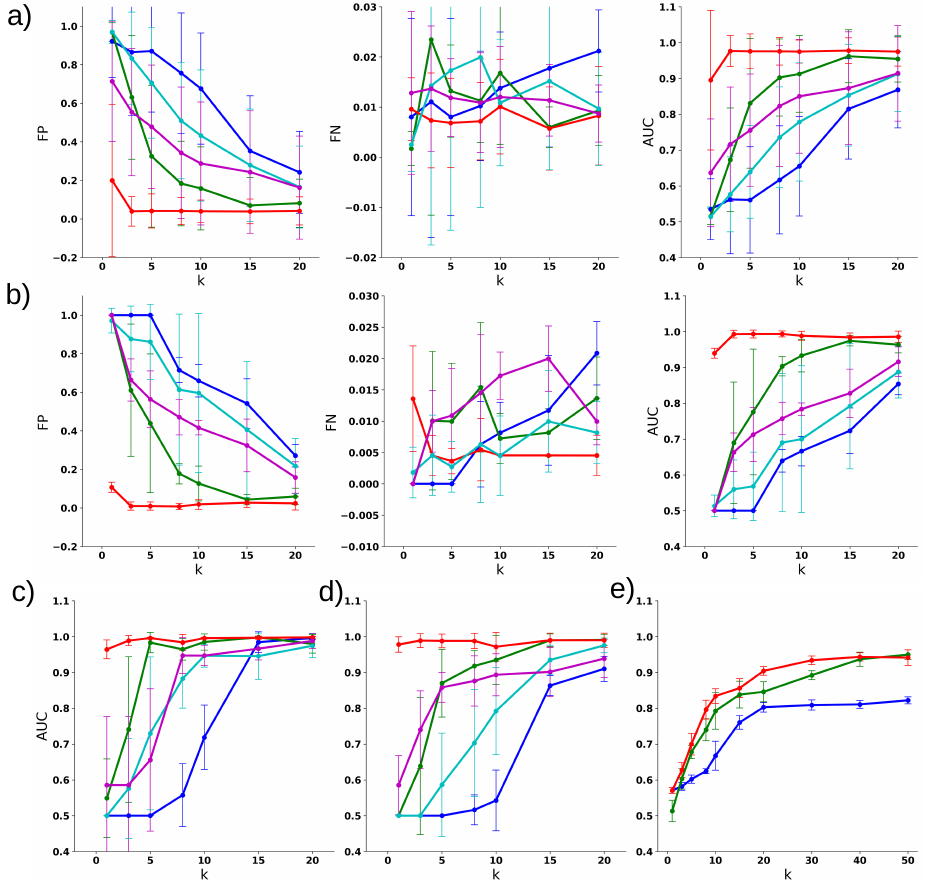
Figure 2. Performance benchmarks of DTA compared to other feature selection methods for disease classification. The blue color denotes PCA, green denotes two-phase, cyan denotes Barabasi, magenta denotes LIMMA, while red denotes DTA geneset: ( a ) the average false-positive, false-Negative, and ROC-AUC score of the SVM classifier over six different disease datasets from TCGA; ( b ) false-positive (FP), false-Negative (FN), and ROC-AUC score for the TCGA-BRCA dataset; ( c ) ROC-AUC score of TCGA-LUSC dataset; ( d ) ROC-AUC score of TCGA-LUAD dataset; and ( e ) ROC-AUC score of multiclass classification for six cancer types from